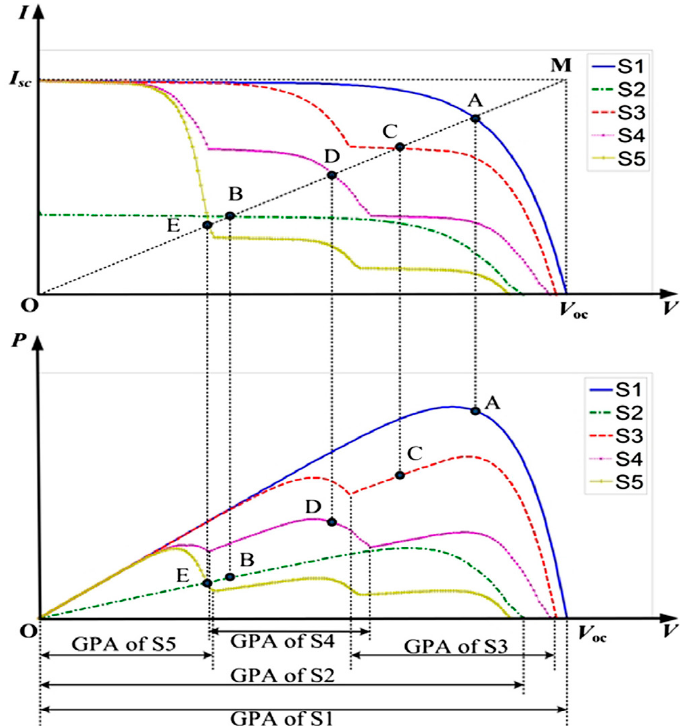
Figure 13. Global peak area relationship between I–V and P–V curves referring to the intersection of a load line.